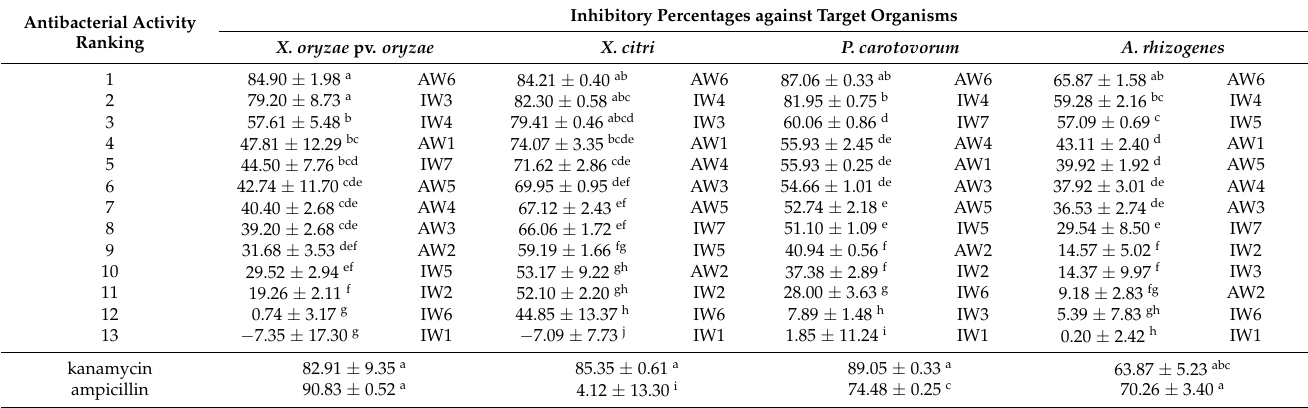
Table 3. Ranking of <3 kDa peptide samples according to inhibitory activity against plant pathogenic bacteria at 6 h after treatment.